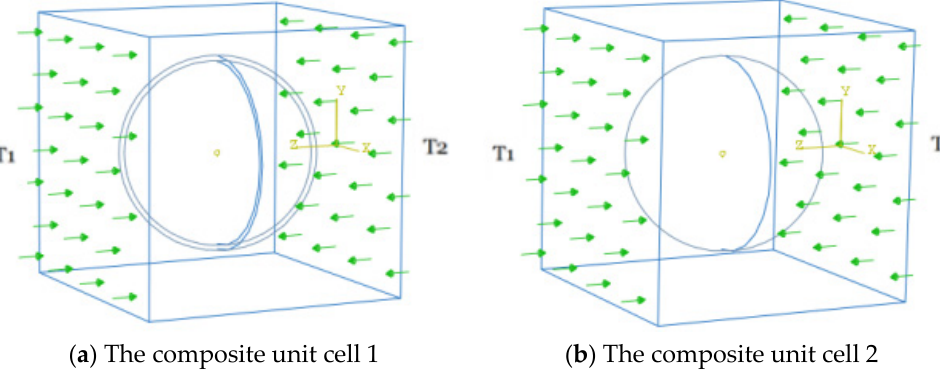
Figure 12. Heat transfer in the two composite systems under applied temperature constraints.